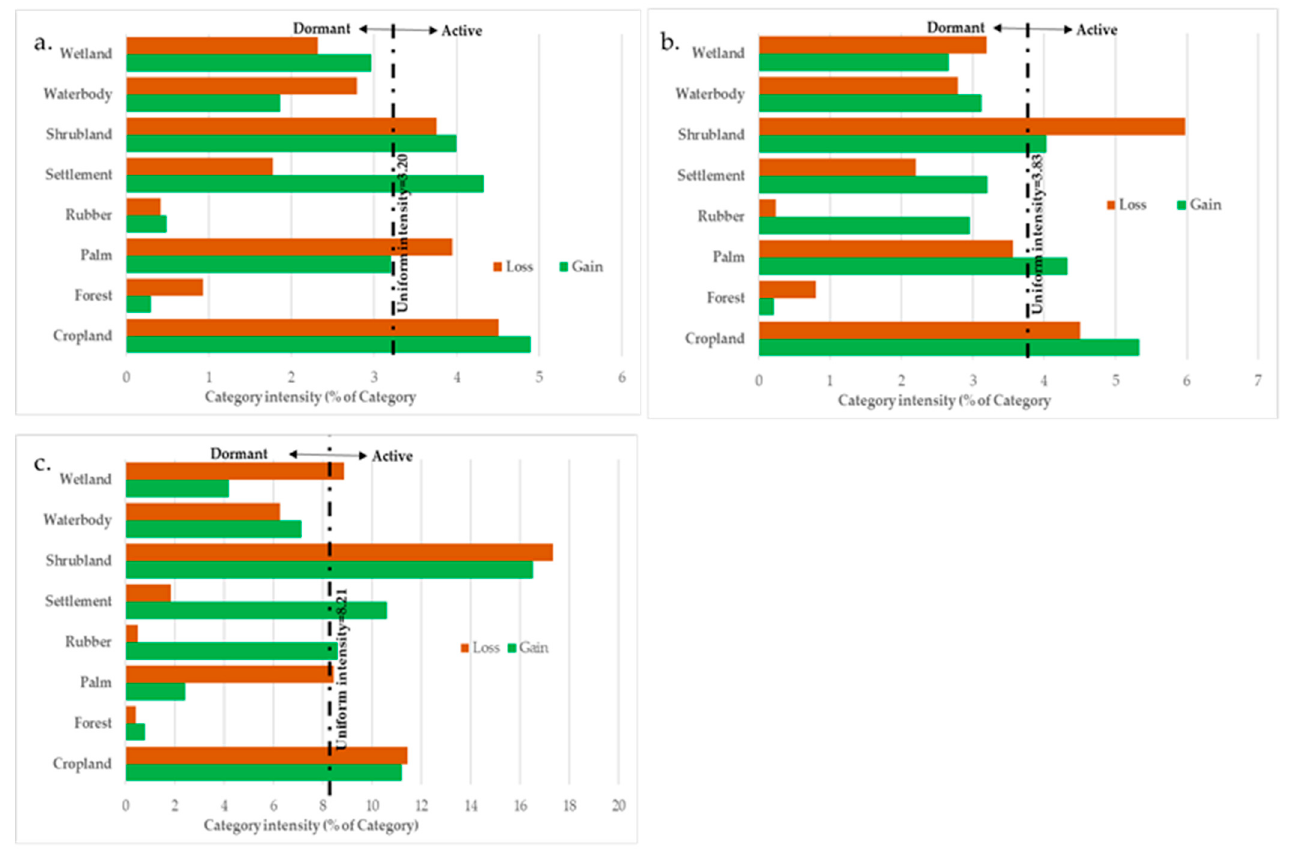
Figure 6. Category level intensities for ( a ) 1986–2002, ( b ) 2002–2015 and ( c ) 2015–2020.